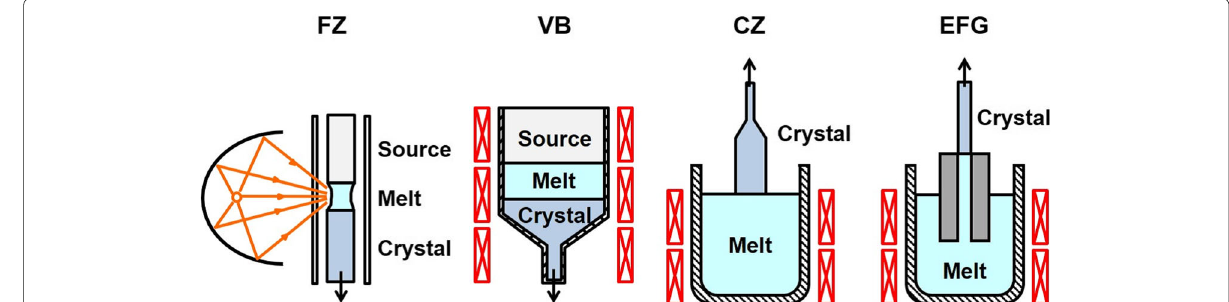
Fig. 3 Melt growth methods for synthesis of β -Ga 2 O 3 bulk single